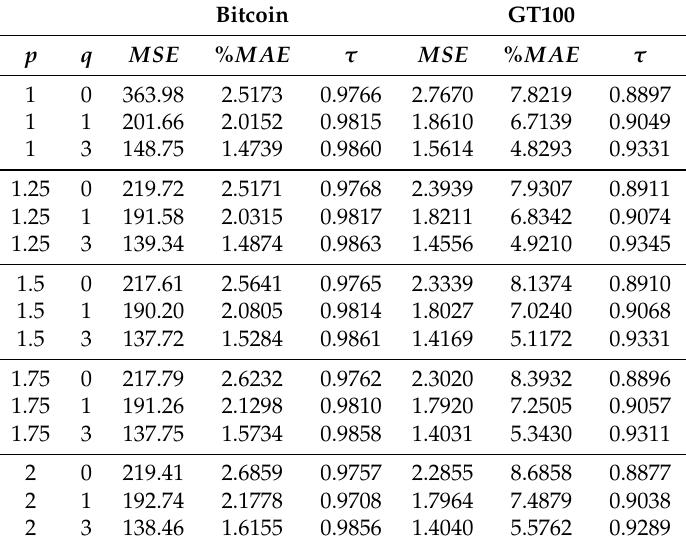
Table 2. Approximation indices for L p -norm F-transform of Bitcoin and GT100 For five values p ∈ { 1,1.25,1.5,1.75,2 } and three orders q ∈ { 0,1,3 } the table shows indices MSE , % MAE , and Kendall τ correlation for the pairs ( f , f ( r ) ) with f ∈ { Bitcoin , GT 100 } .